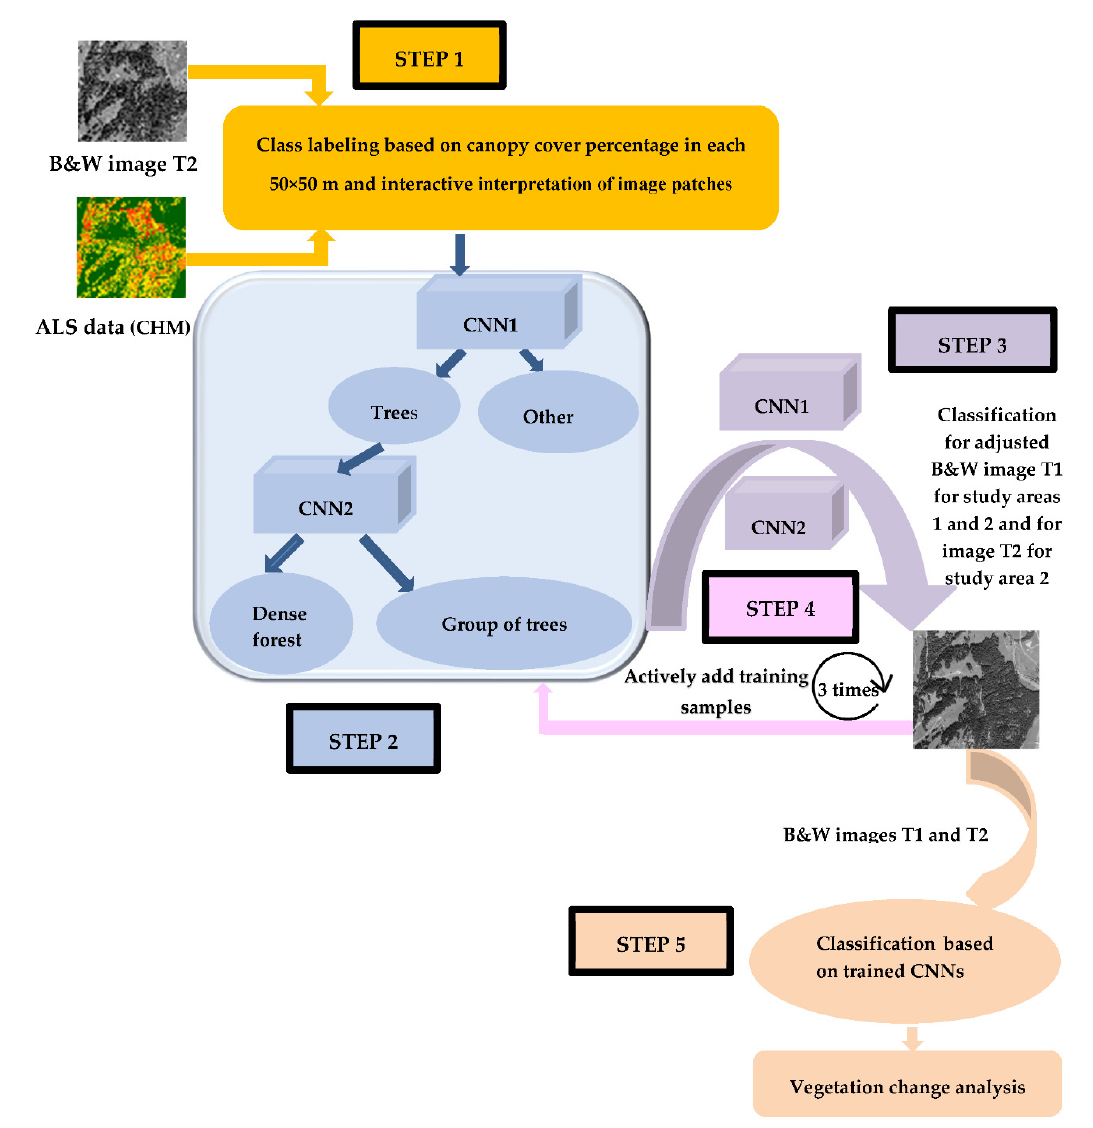
Figure 9. Overview of the workflow with the five steps.